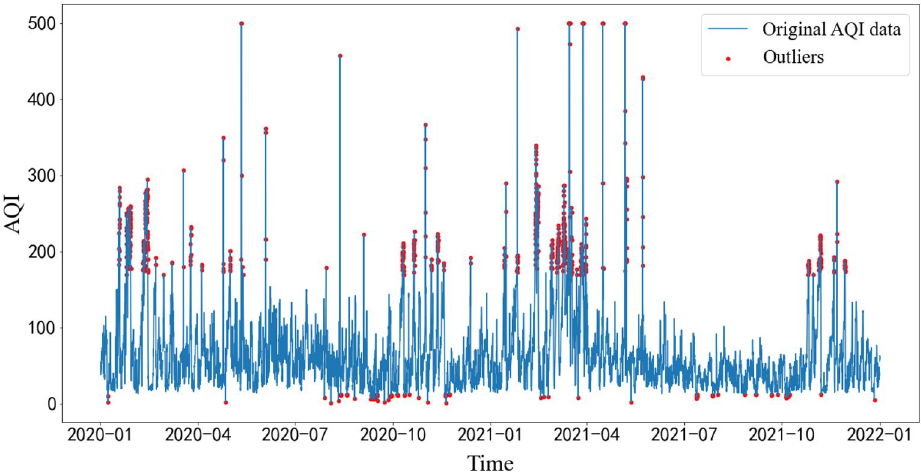
Figure 4. Outlier